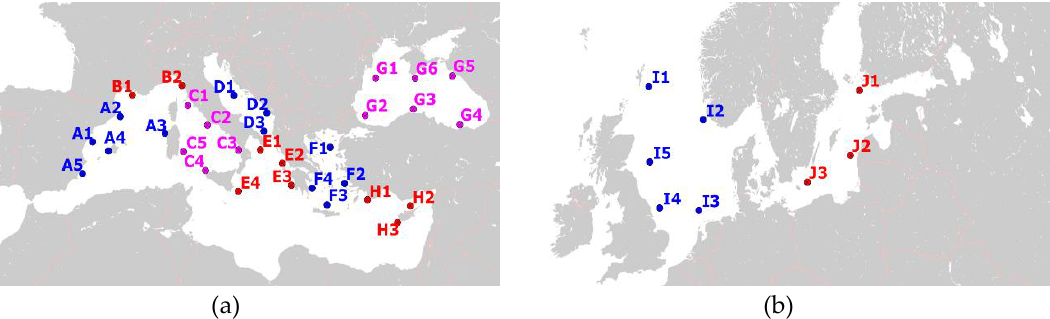
Figure 2. The geographical locations of the 40 reference points considered in the study. ( a ) Zones A, B, C, D, E, F, H, and G correspond to the Balearic, Ligurian, Tyrrhenian, Adriatic, Ionian, Aegean, Levantine and Black seas, respectively; ( b ) Zone I corresponds to the North Sea and Zone J to the Baltic Sea. Table 1. The geographical locations and the characteristics of the considered reference points; the depths are relative to the mean sea level